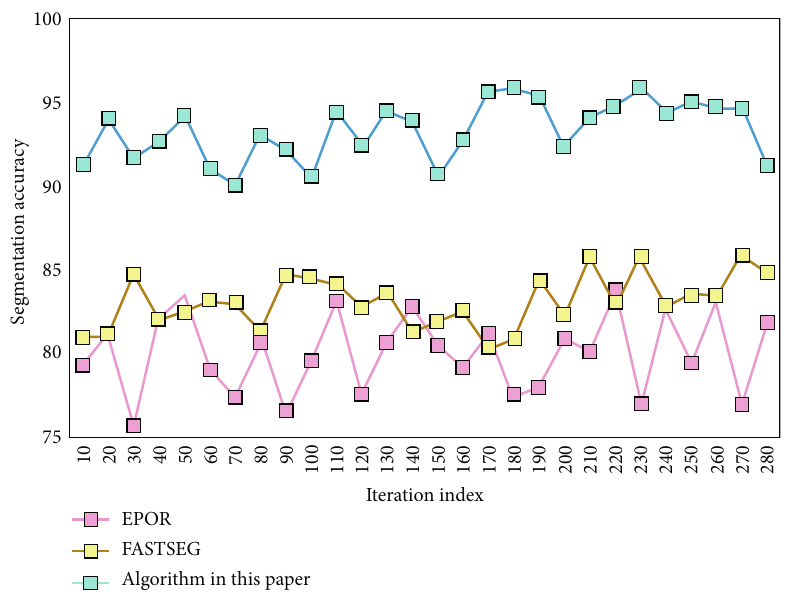
Figure 5: Segmentation accuracy of the algorithm.